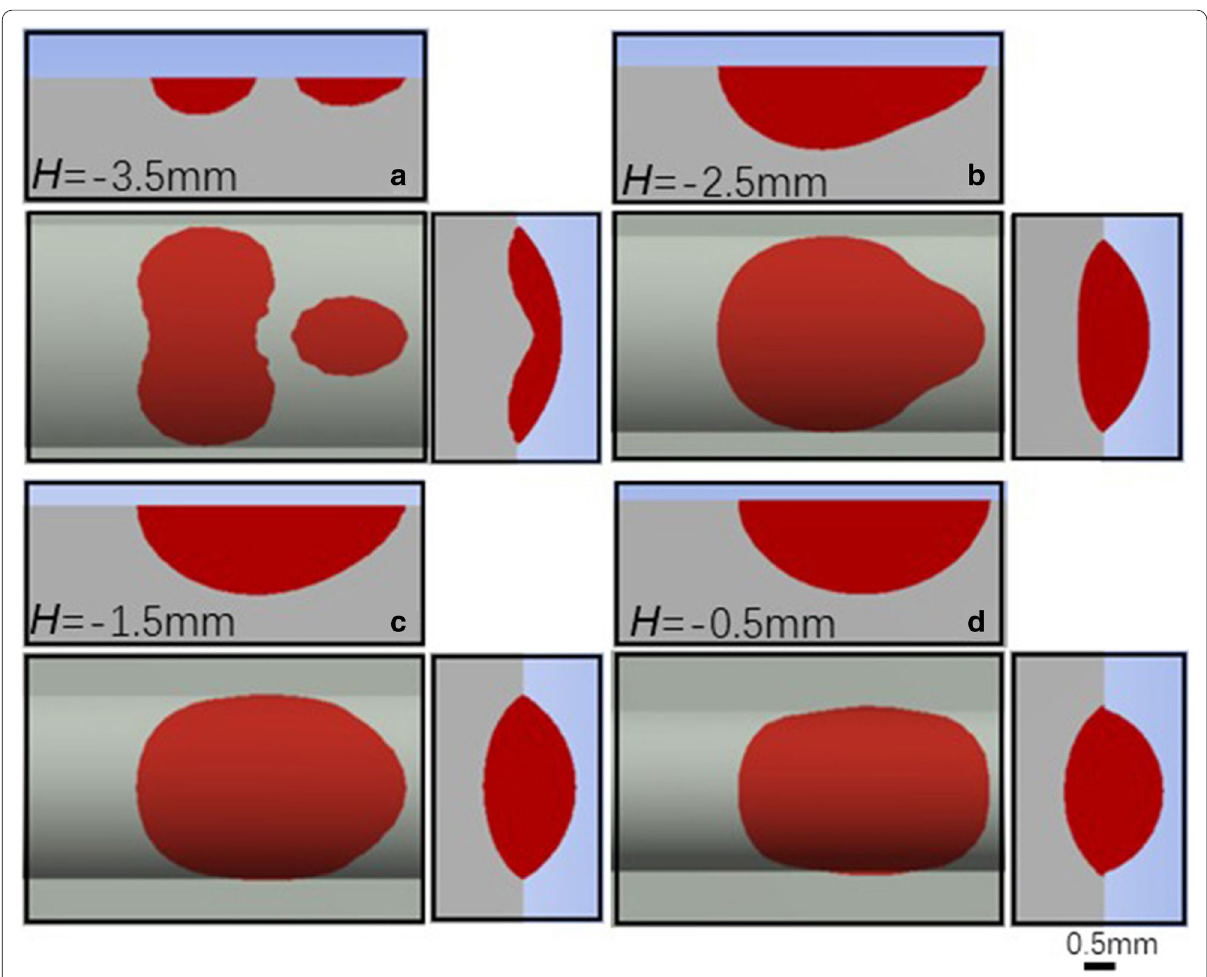
Figure 16 Molten pool shapes at various defocus distances: a H